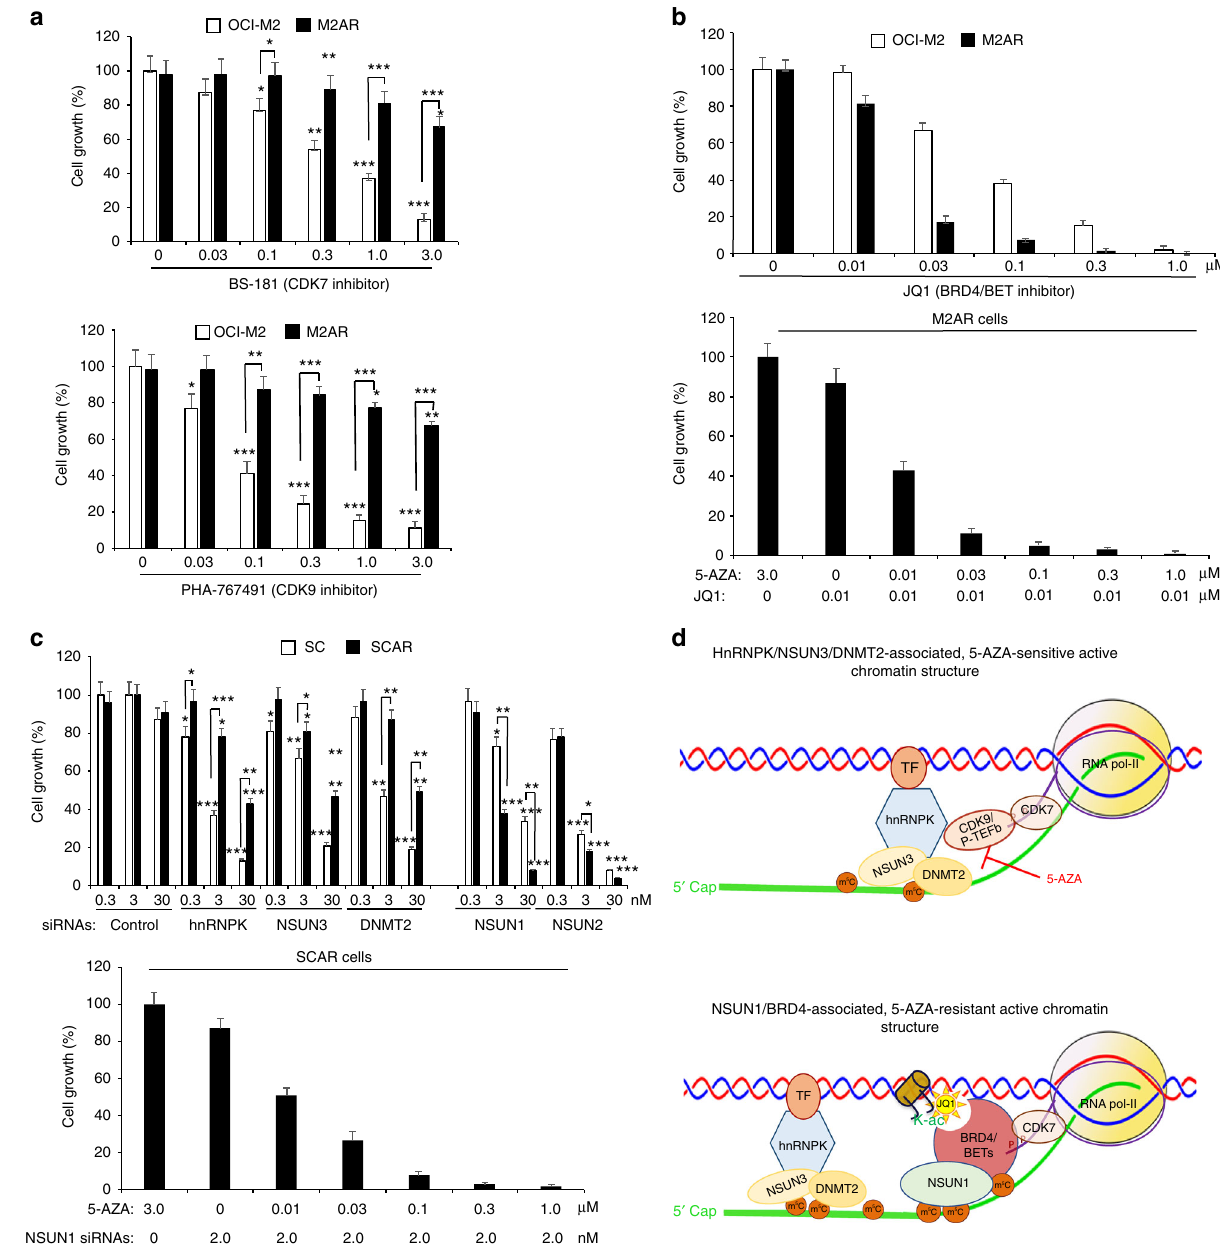
Fig. 8 Differential growth inhibition with CDK7/9 inhibitors, BRD4 inhibitor JQ1 and RCMT siRNAs in 5-AZA-sensitive vs. 5-AZA-resistant leukaemia cells. a Measurements of the cell growth rates in OCI-M2 and M2AR cells treated with the CDK7 inhibitor, BS-181, and the CDK9 inhibitor, PHA-767491, at various concentrations for three days. b Measurements of the growth rates of OCI-M2 and M2AR cells treated with JQ1 at various concentrations for 3 days and the synergic growth inhibition in the M2AR cells treated with a low dose (0.01 μ M) of JQ1 plus 5-AZA at various concentrations. c Measurements of the growth inhibition by the siRNAs targeting various RCMTs in SC and SCAR for 3 days and the synergic growth inhibition in the SCAR cells treated with 2 nM NSUN1 siRNAs plus 5-AZA at various concentrations. d A schematic presentation of the proposed working model of distinct 5-AZA responsive/resistant chromatin structures in 5-AZA-sensitive and 5-AZA-resistant leukaemia cells PL-RCA signals in the 5-AZA-sensitive AML/MDS bone marrow data suggested that mRNA:m 5 C may play an important role in cells (Fig. 10a). Quantitative analysis of the PL-RCA signal mediating 5-AZA resistance in MDS and AML. strength by manually counting the percentages of those PL-RCA- positive cells per 500 DAPI-positive cells demonstrated a sig- NSUN1/BRD4-associated active chromatin in clinical speci- ni fi cant increase in the PL-RCA signals of co-localization of mens . We performed the PL-RCA on the 5-AZA-sensitive and 5- NSUN1 and RNA-pol-II CRD-S2P in the 5-AZA-resistant AML/ AZA-resistant AML/MDS bone marrow specimens. This experi- MDS bone marrow specimens compared to the 5-AZA-sensitive ment demonstrated very strong PR-RCA signals of co- AML/MDS bone marrow specimens. The PL-RCA experiments localization of NSUN1 and RNA-pol-II CTD-S2P in the 5- with anti-NSUN1 and BRD4 antibodies performed in the same AZA-resistant AML/MDS bone marrow cells and much weaker 10 NATURE COMMUNICATIONS | (2018) 9:1163 | DOI: 10.1038/s41467-018-03513-4 |